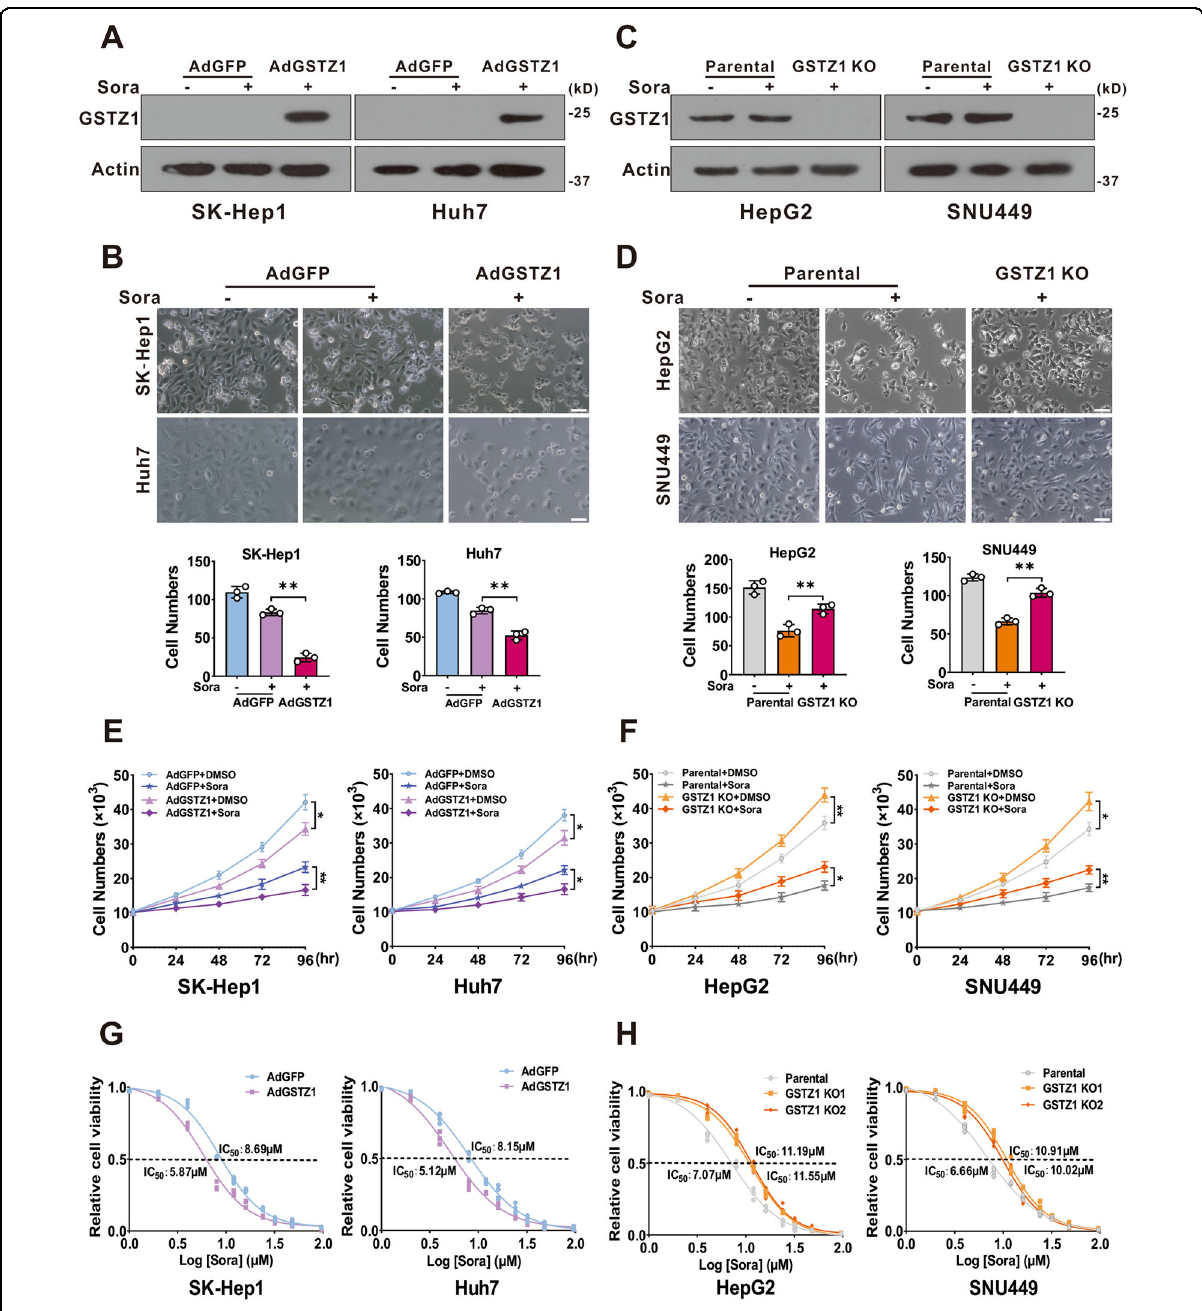
Fig. 2 GSTZ1 knockout promotes sorafenib resistance in HCC cells. A Overexpression of GSTZ1 was con fi rmed by immunoblot assay. B Morphological phase-contrast images (top) and quanti fi cation (bottom) of GSTZ1-OE cells after treatment with or without sorafenib (10 μ M) for 24 h. C Knockout of GSTZ1 was con fi rmed by immunoblot assay. D Morphological phase-contrast images (top) and quanti fi cation (bottom) of GSTZ1- KO cells after treatment with or without sorafenib (10 μ M) for 24 h. Scale bar = 10 μ m. E , F Cell growth curve. GSTZ1-OE ( E ) and GSTZ1-KO ( F ) cells were treated with or without sorafenib (10 μ M). G , H The IC 50 of GSTZ1-OE ( G ) and GSTZ1-KO ( H ) cells were determined using the CCK-8 assay. For western blotting, 50 μ g protein was loaded per well. DMSO: dimethyl sulfoxide, Sora: sorafenib. Values represent the mean ± SD ( n = 3). * p < 0.05, ** p < 0.01, Student ’ s t -test (two